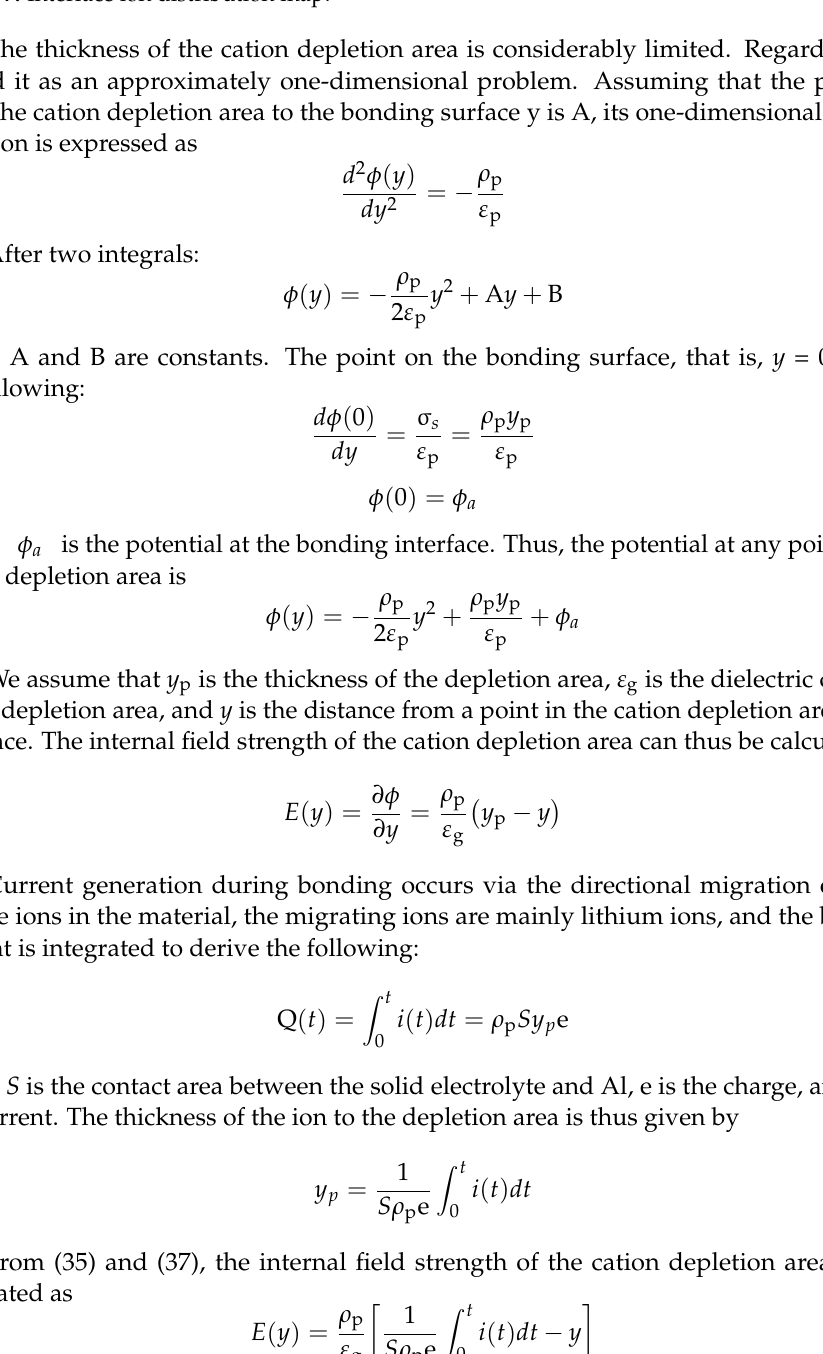
Figure 7. Interface ion distribution map.